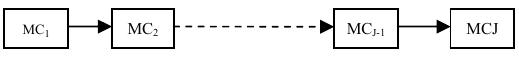
Fig. 1. Single-Product production system